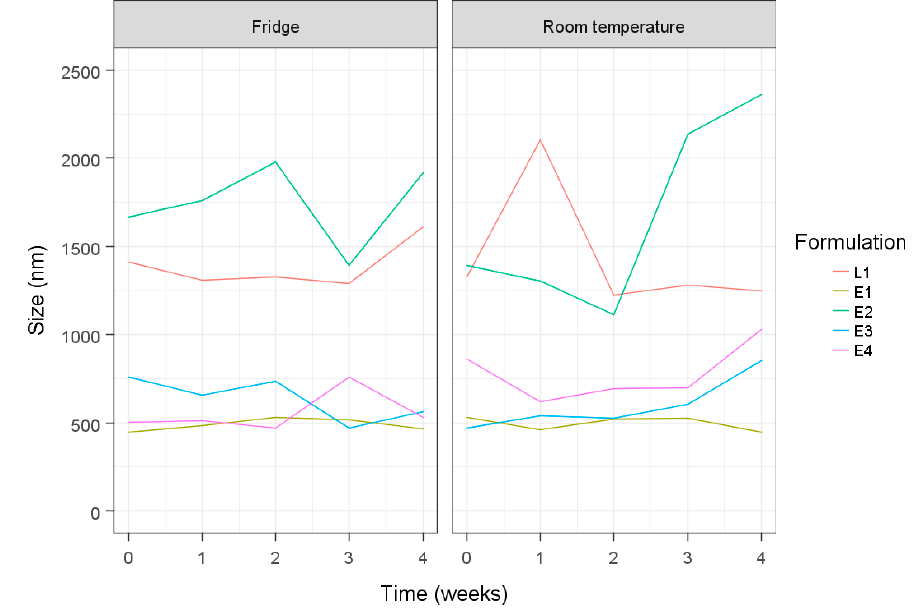
Figure 2. Niosome size measurements of all formulations (before probe sonication) kept under fridge (4 ± 2 °C) and room temperature (23 ± 2 °C) conditions over a four-week